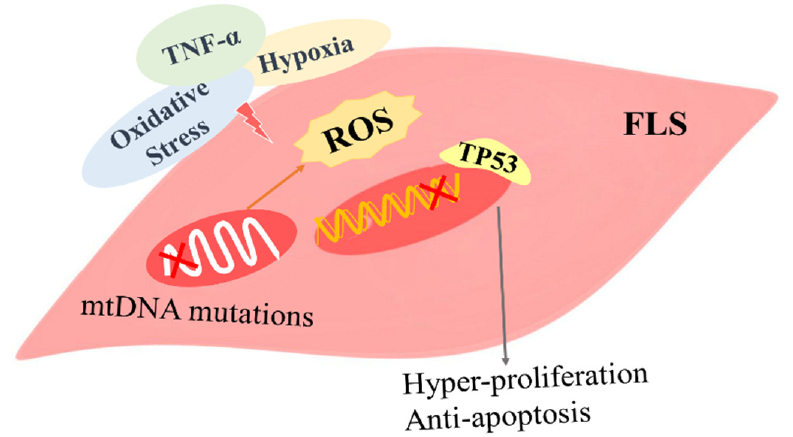
Figure 2. Role of reactive oxygen species (ROS)-induced gene mutations in fibroblast synovial cells. The synovial microenvironment of RA with hypoxia, high ROS and high inflammatory factors may lead to genetic imprinting of FLS by somatic and mitochondrial DNA mutations (as shown in the Red Cross), which lead to FLS proliferation and